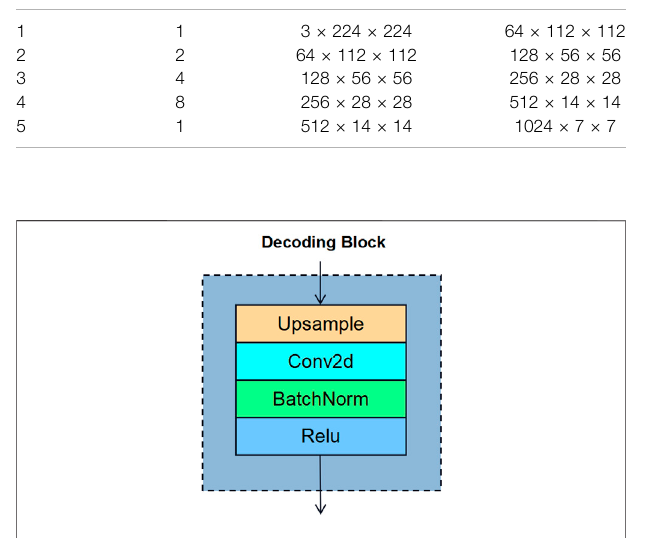
FIGURE 4 | Sketch of decoding block architecture.